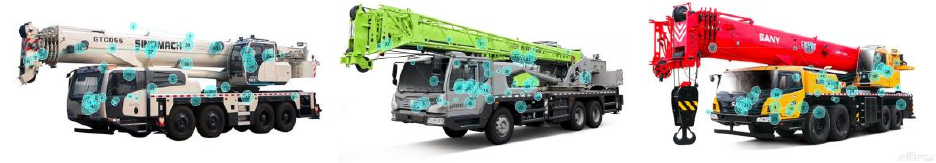
Figure 6. Partial visual trace of participants. Table 5. The mean score of each visual-interest